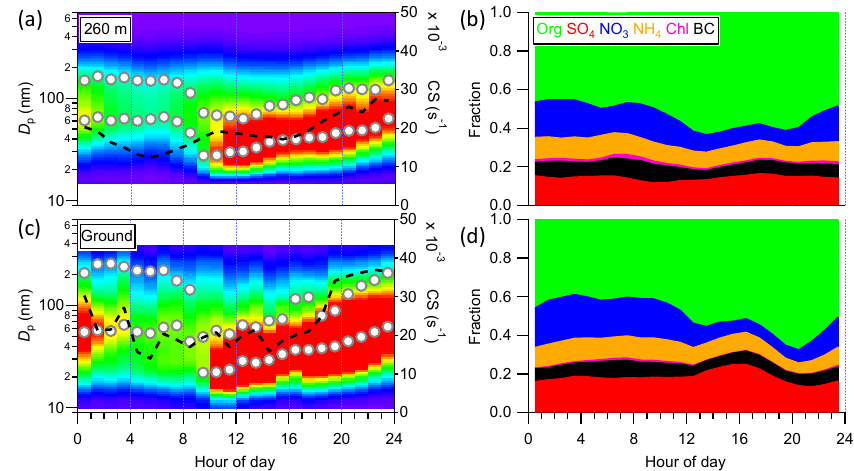
Figure 7. Average diurnal evolution of particle number size distributions and aerosol composition at (a, b) 260m and (c, d) ground level for the new particle growth events. The dashed lines in panels (a) and (c) are the diurnal cycles of